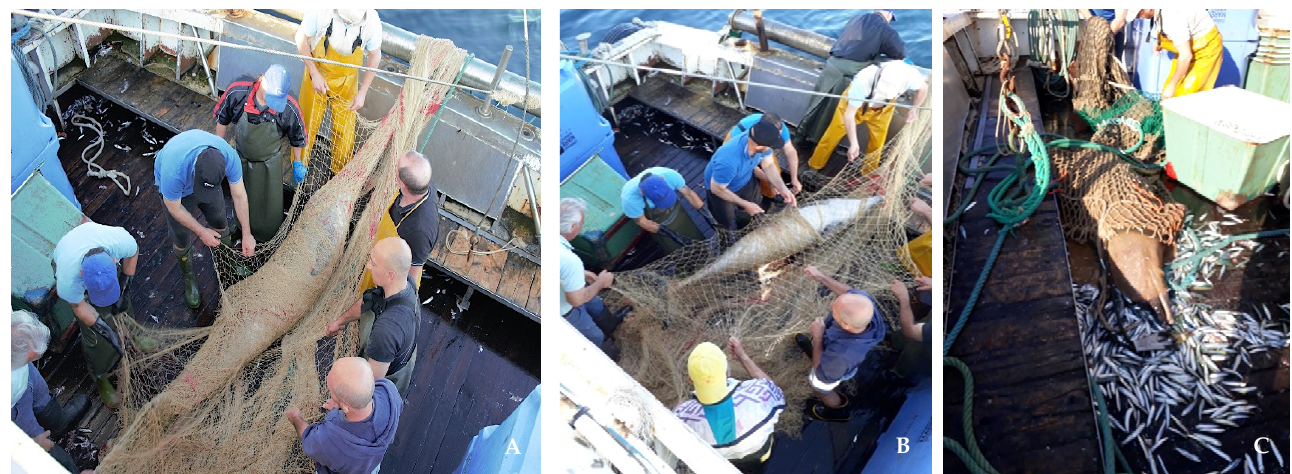
Figure 1. The three bycatches during the disentanglement operations, two were wrapped in the fishing net ( A , B ) and one inside the codend ( C ). Gulf of Venice, 18 May 2017 h 7:00 a.m., 45°18826 ′ N–12°41804 ′ .